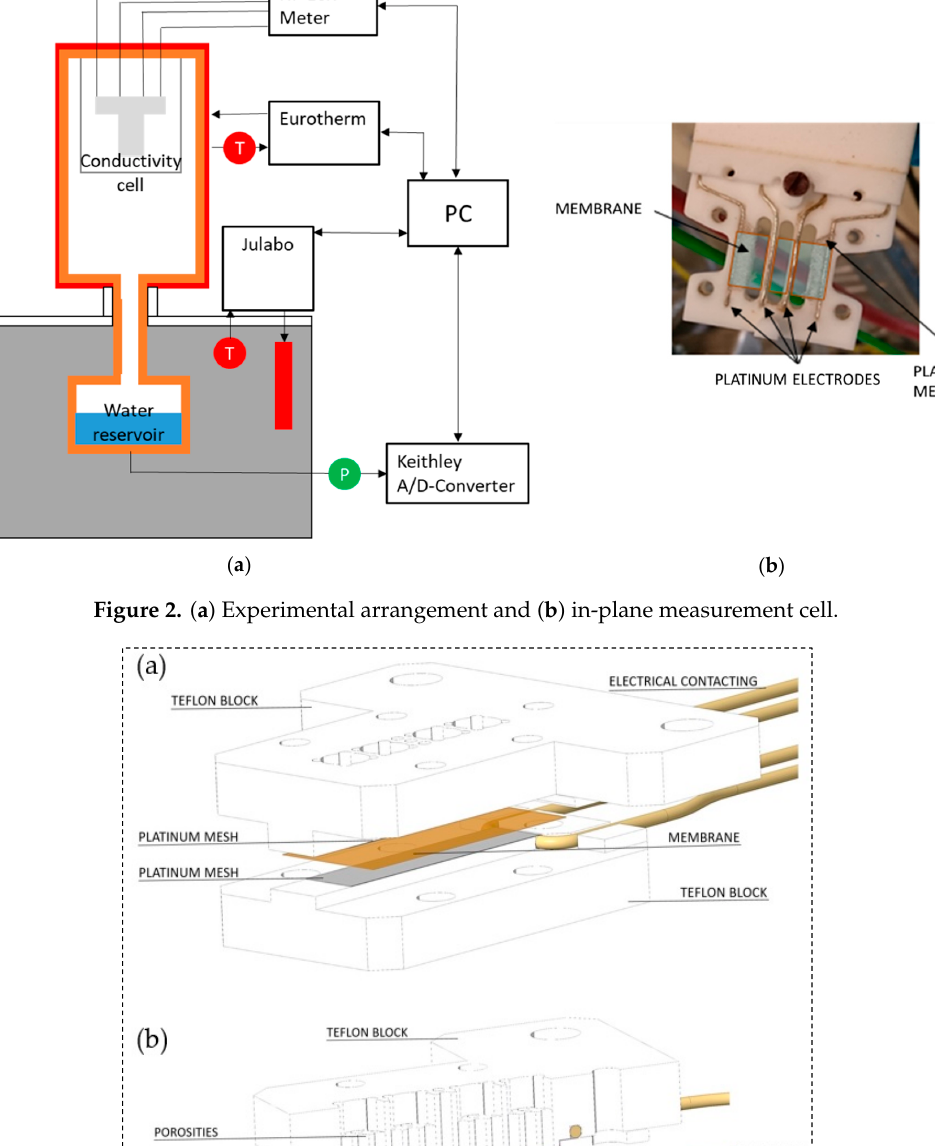
Figure 2. ( a ) Experimental arrangement and ( b ) in-plane measurement cell.